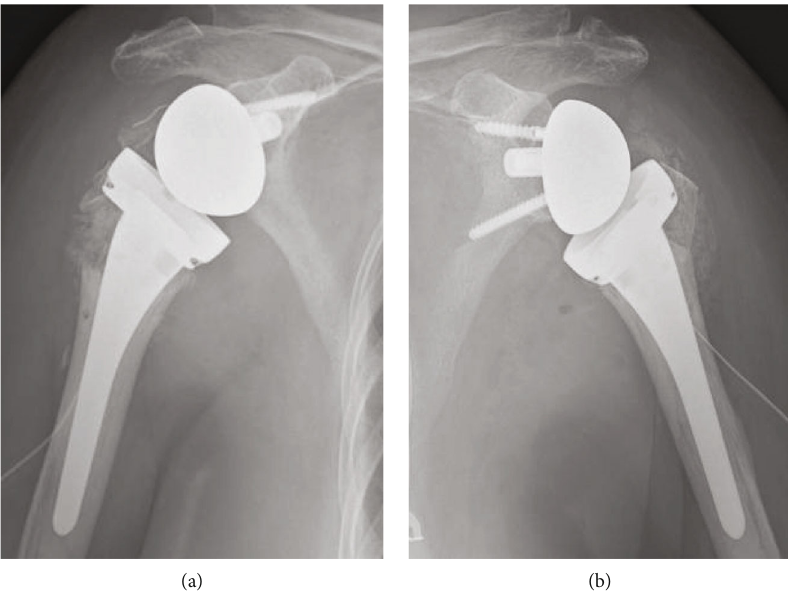
Figure 4: Postoperative radiographs after bilateral reverse shoulder arthroplasty: (a) right shoulder and (b) left